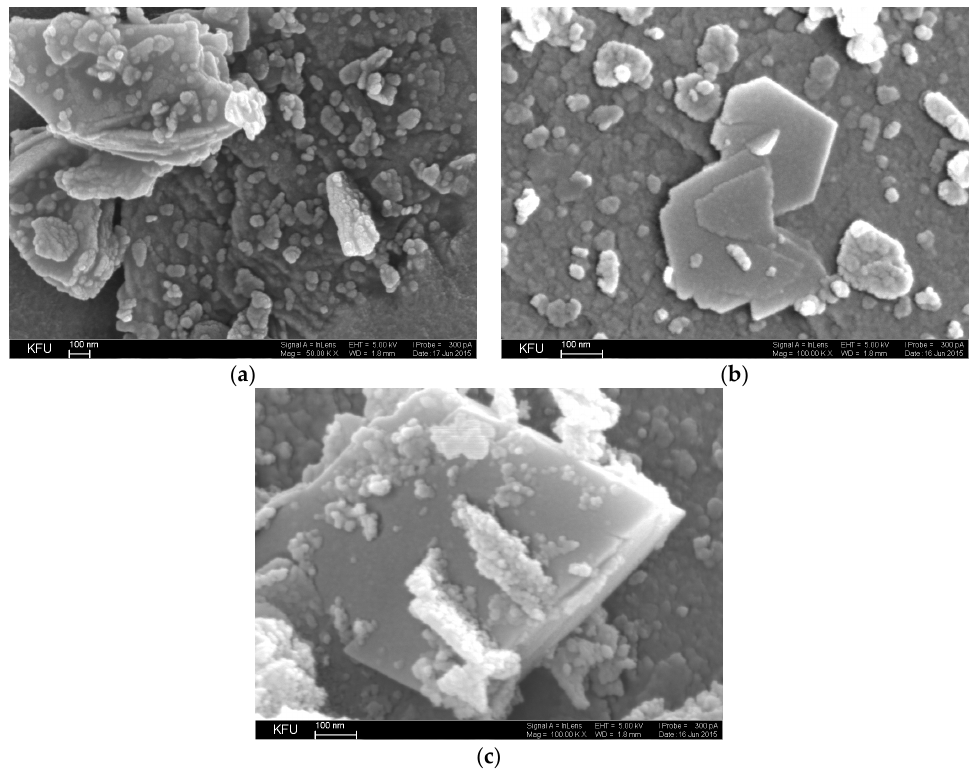
Figure 2. SEM images of external surface of ( a ) starting χ‐ Al 2 O 3 particle, its products of HTT at ( b ) Т = 190 ° С , рН = 4.0, τ = 60 min; ( c ) Т = 180 ° С , рН = 9.2, τ = 60 min.